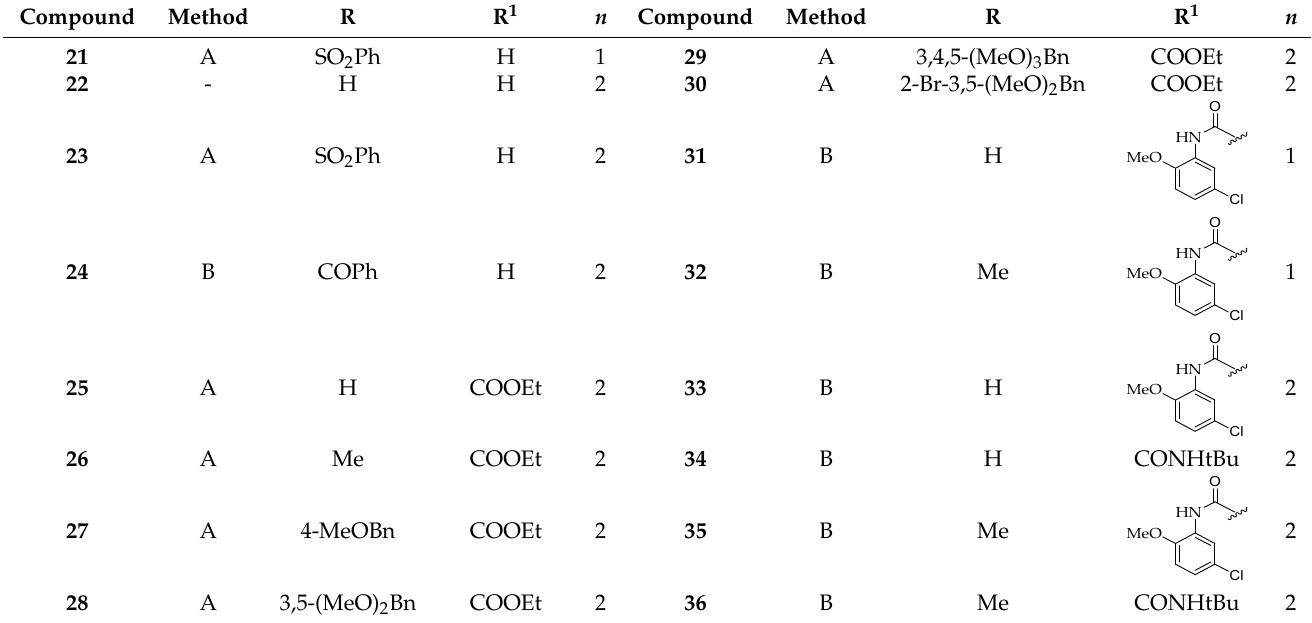
Table 1. Overview of α -bromo-ketones 21 – 36 . Table 2. [1,3]Thiazolo[5,4 ‐ g ]indole ‐ 2 ‐ amines 37 – 45 and pyrrolo[3’,2’:6,7]cyclohepta[1,2 ‐ d ][1,3]thiazol ‐ 2 ‐ amines 46 – 71